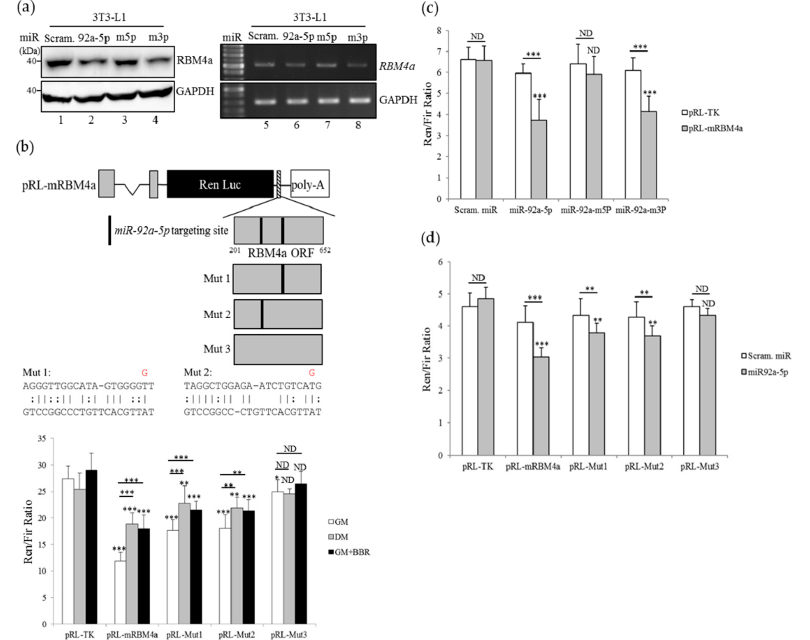
Figure 5. miR-92a reduces the expression of RBM4a by targeting the RBM4a coding region. ( a ) Total RNAs and cell lysates were extracted from 3T3-L1 cells transfected with a scramble miRNA, or an expressing vector generating wild-type (WT) miR-92a-5p or mutant miR-92a . RT-PCR and